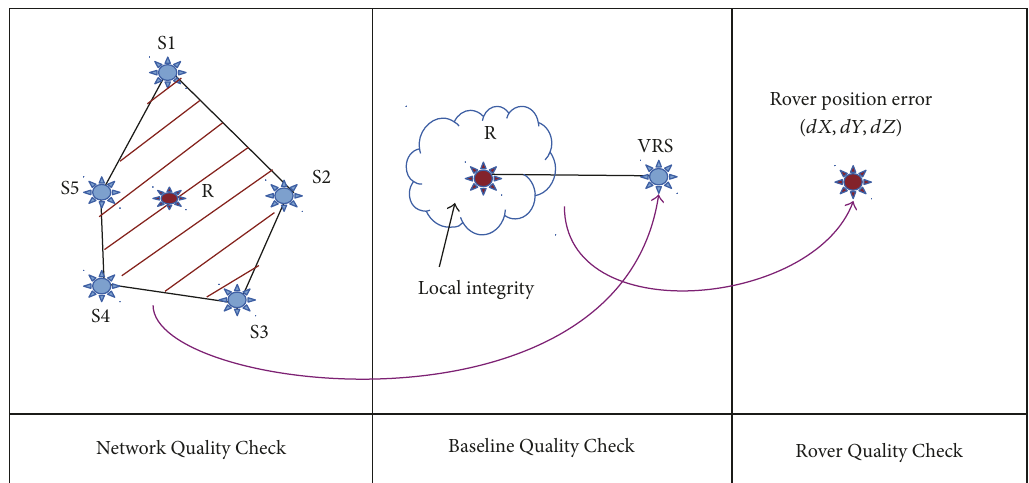
Figure 1: NRTK processing chain. The left panel shows NRTK module that produces the network corrections. The curved line indicates the output generated by the network module. Middle panel shows the local and the baseline processing module. Right panel shows the rover position solution